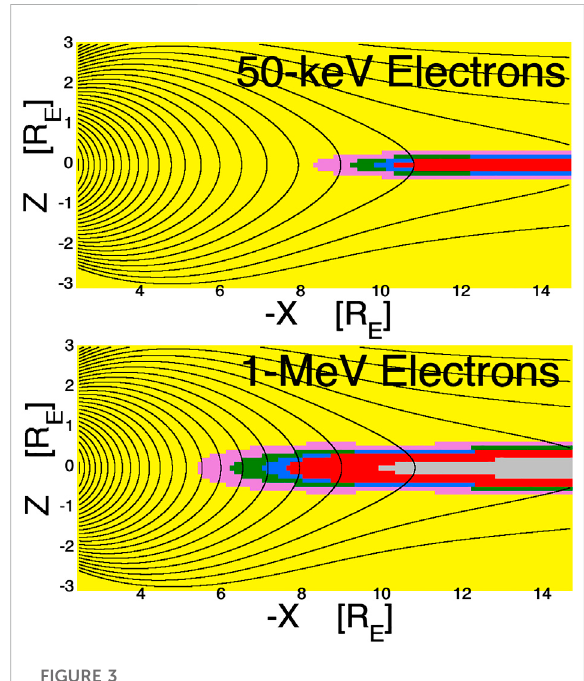
FIGURE 3 Loss-cone-shift maps for electrons as in Figure 2, but for no dipoletiltwithrespecttotheSun-Earthline.Magnetic- fi eldlinesin the nightside magnetosphere in the noon-midnight meridian are drawn as the black curves using the T96 magnetic- fi eld model. The colored shading is the calculated eastward shift of the local atmospheric loss cone for 50-keV electrons (top panel) and for 1-MeV electrons (bottom panels) based on the T96 magnetic- fi eld model. The color scheme is yellow (shift < 0.5 ° ), pink (shift 0.5 ° – 1 ° ), green (shift 1 ° – 1.5 ° ), blue (shift 1.5 ° – 2 ° ), red (shift 2 ° – 10 ° ), and gray (shift > 10 °